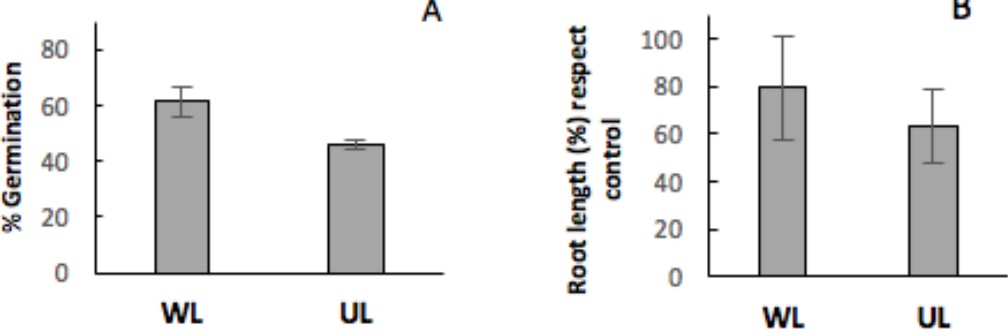
Figure 6. Effect of the presence washed leaf litter (WL) and untreated leaf litter (UL) from C. ladanifer on germination percentage (panel ( A )) and root length with respect to the control (panel ( B )). These parameters were quantified as the mean of all the analysed species.